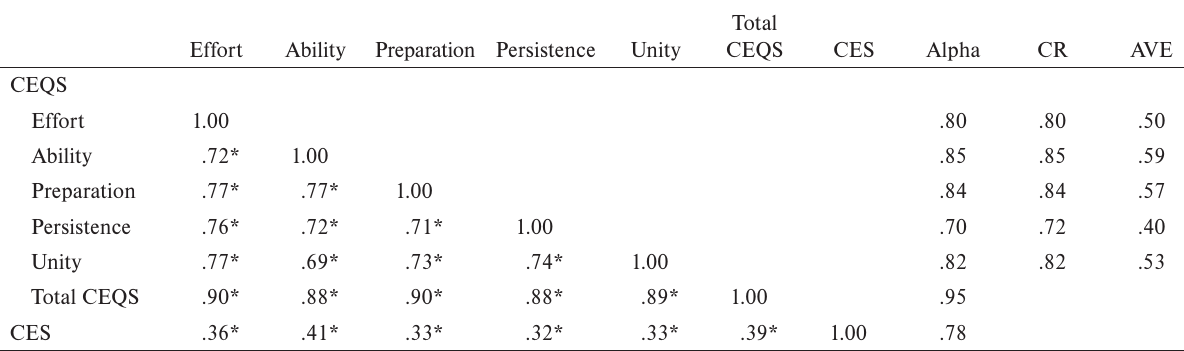
Correlations and reliability estimates for the T-CEQS and